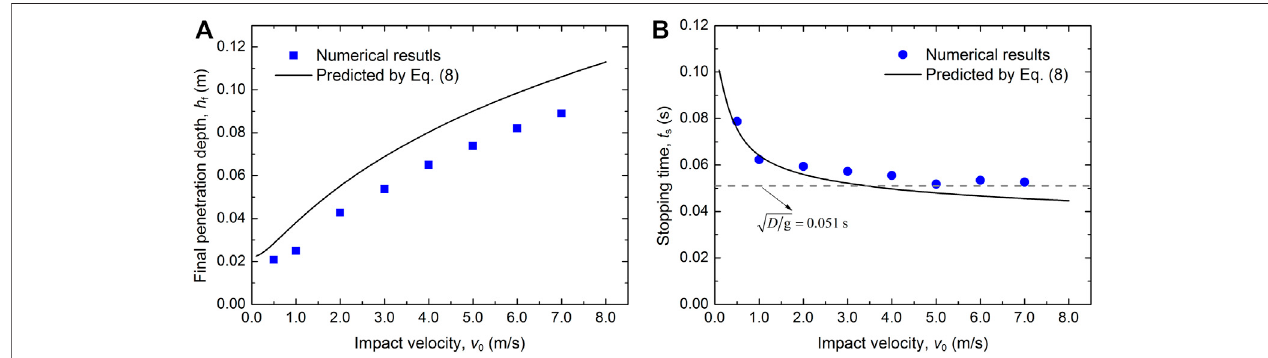
FIGURE8| Dependencesof (A) the fi nalpenetrationdepthand (B) thestoppingtimeontheimpactvelocity.Theblackcurvesshowthe fi nalpenetrationdepthand stopping time predicted by Eq. 8 using the parameters d 1 and k calculated from Eqs 10, 11 .